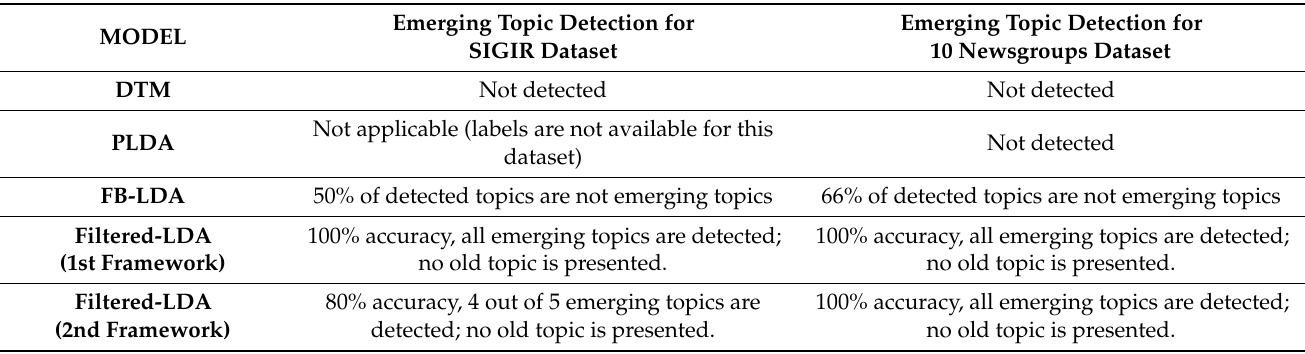
Table 11. Summary of experimental